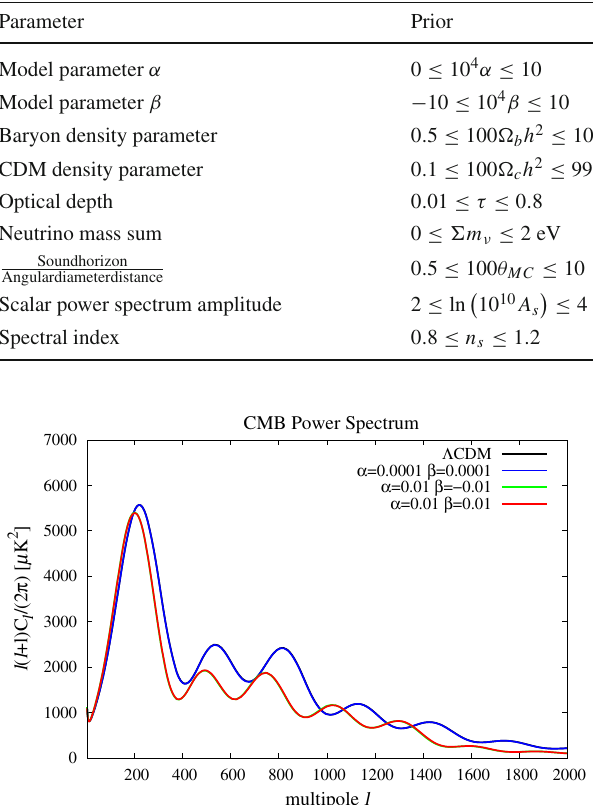
Table 2 Priors for cosmological parameters with (cid:2) = 3 α H 2 + / H 2 + (cid:2) 3 β H 4 0 0